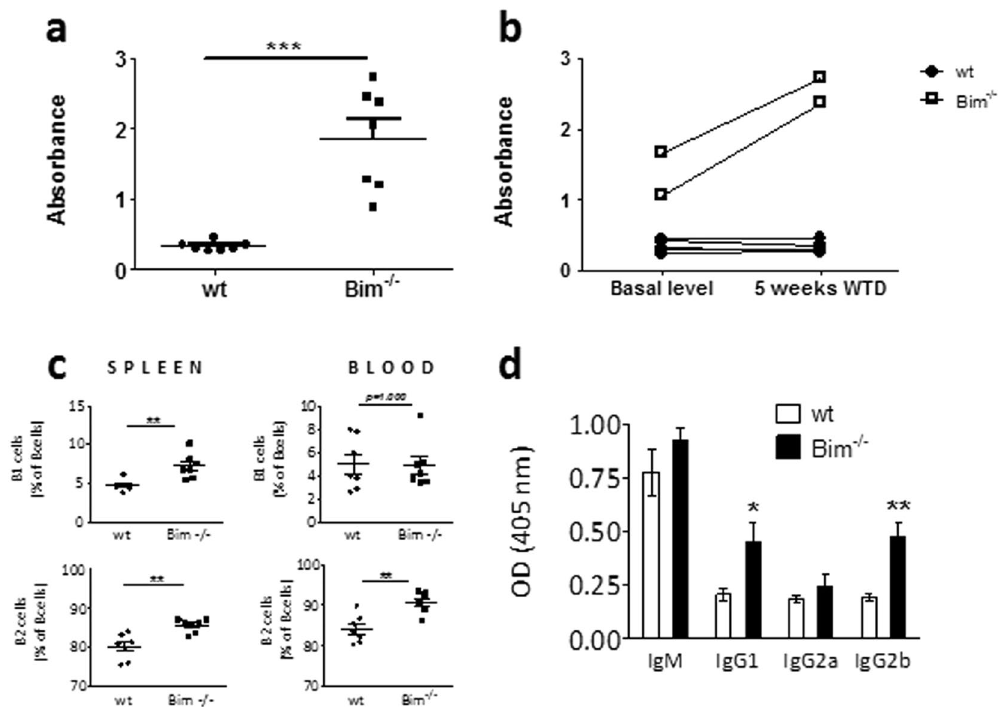
Figure 4. Bim deficiency alters the humoral response in atherosclerotic mice. ( a ) After 5 weeks of WTD, anti- dsDNA autoantibodies in sera of wt and bim − / − chimeric mice (n = 7) were quantified by ELISA. ( b ) Paired anti-dsDNA autoantibody determination in sera before start of WTD and after 5 weeks of WTD in 5 wt and 2 bim − / − chimeric mice. 2-way ANOVA test shows highly significant effects of both the bim − / − phenotype as well as the induction of the diet (p < 0.0001). ( c ) B1 and B2 cells in the blood and spleen of wt or bim − / − chimeric mice after 5 weeks of WTD were defined as CD19 + , CD220 + , CD11b + (B1) and CD19 + , CD220 + , CD5 − , CD11b − (B2) respectively using flow cytometry (n = 7). ( d ) oxLDL specific antibody titers were measured by ELISA in sera of wt or bim − / − chimeric mice after 10 weeks of WTD (n = 12). Data is presented as mean ± SEM. * p < 0.05, ** p < 0.01, *** p <